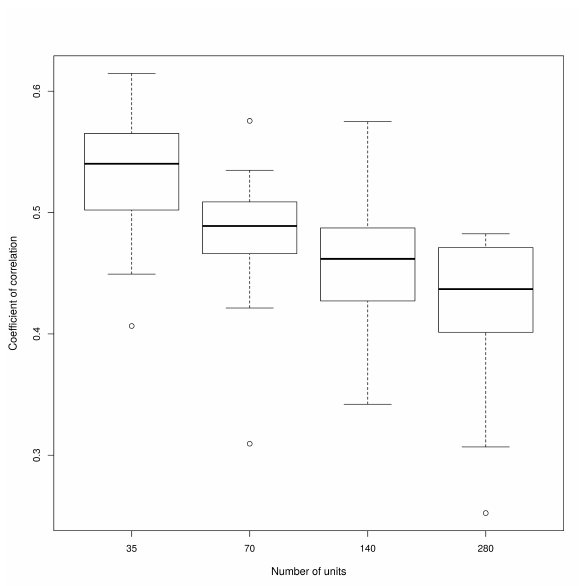
Figure 2: Variation of the Pearson coefficient between the defor- estation rate and the slope due to change in the number of units